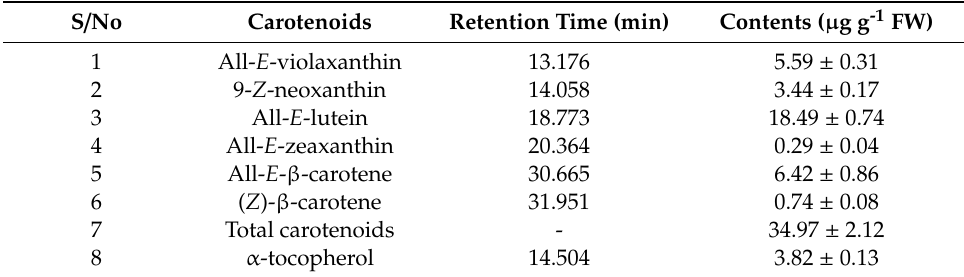
Table 4. Carotenoid and tocopherol contents in the leaf tissues of Mertensia maritima .